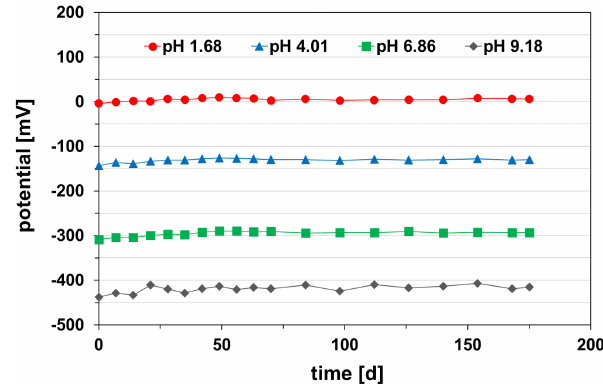
Figure 10. Potential stability of a LTCC-based pH sensor at 25 ◦ C in standard buffer solutions.